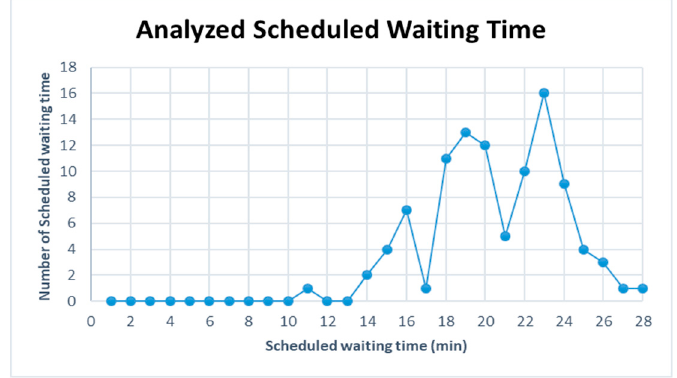
Figure 19. Analyzed Scheduled Waiting Time for Case 5.